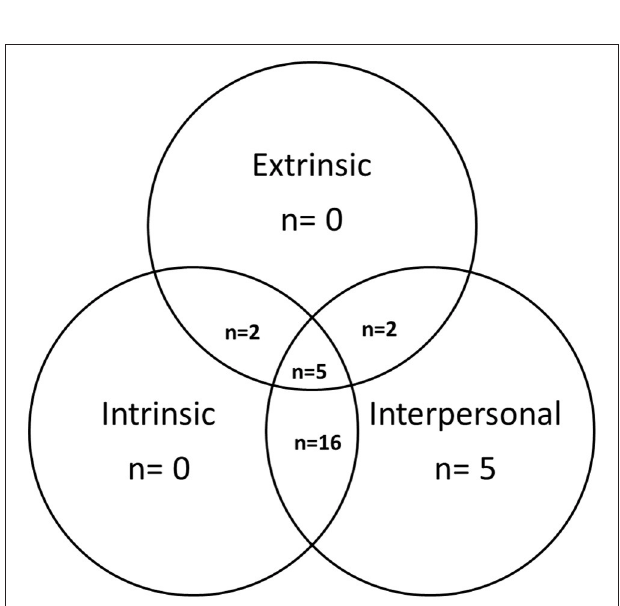
FIGURE 2 | Diagrammatic illustration of the included studies highlighting the factors that influence youth career choices. The figure shows the number of studies focusing on each of the three factors (intrinsic, extrinsic and interpersonal).